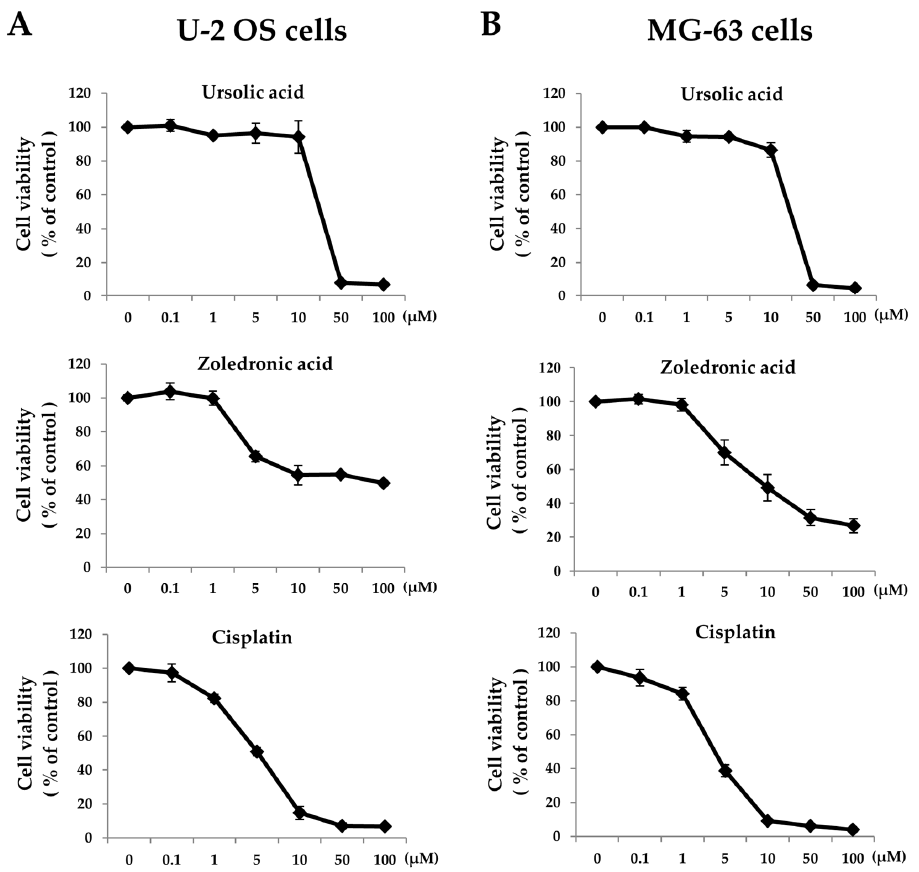
Figure 1. Zoledronic acid, ursolic acid, and cisplatin differentially affect osteosarcoma cell viability. MTT assays were performed with U-2 OS cells ( A ); or MG-63 cells ( B ) treated with either Zoledronic acid (ZOL), ursolic acid (UA), or cisplatin (CPT) at the indicated concentrations for 72 h. Three independent experiments were conducted.